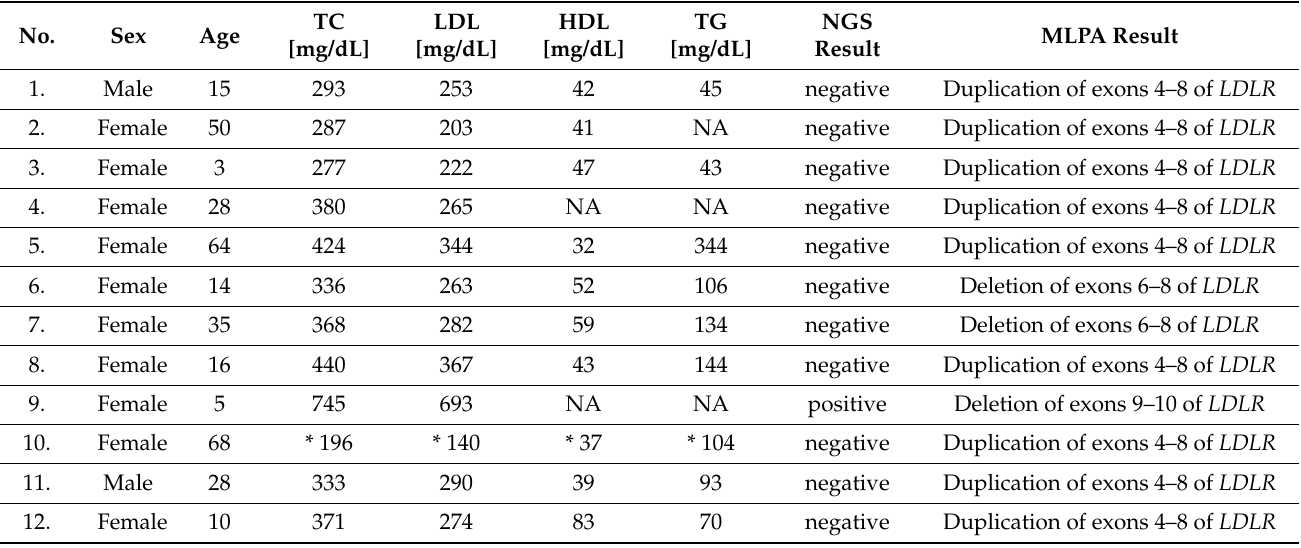
Table 1. Patients with identified FH-related CNV (copy number variation) and obtained genetic